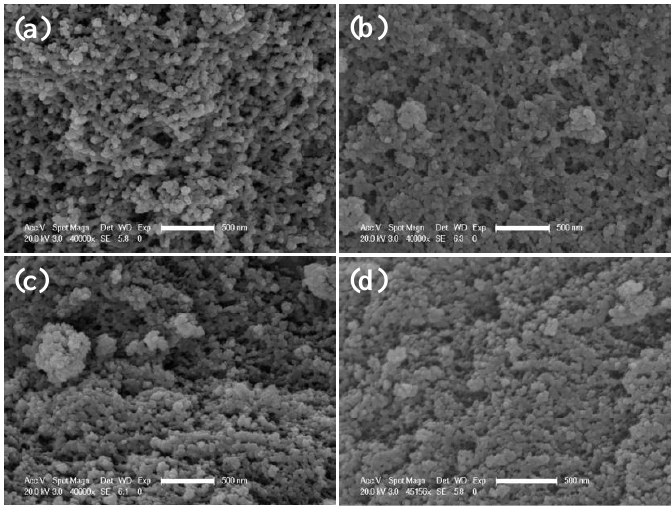
Figure 3. SEM images of CO 2 -SPD aerogel before ( a ) and after ( b ) the first thermal shock and ethanol-SPD aerogels before ( c ) and after ( d ) the first thermal shock (Scale bar: 500 nm).